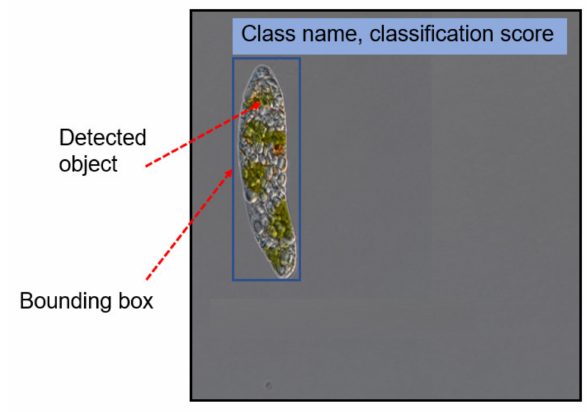
Figure 2. Illustration of the object detection